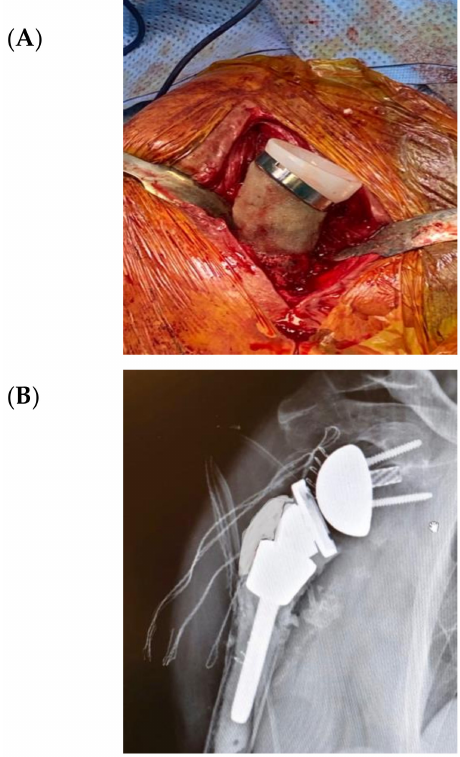
Figure 6. Revision final result. ( A ) Introperative image; ( B ) Postoperative